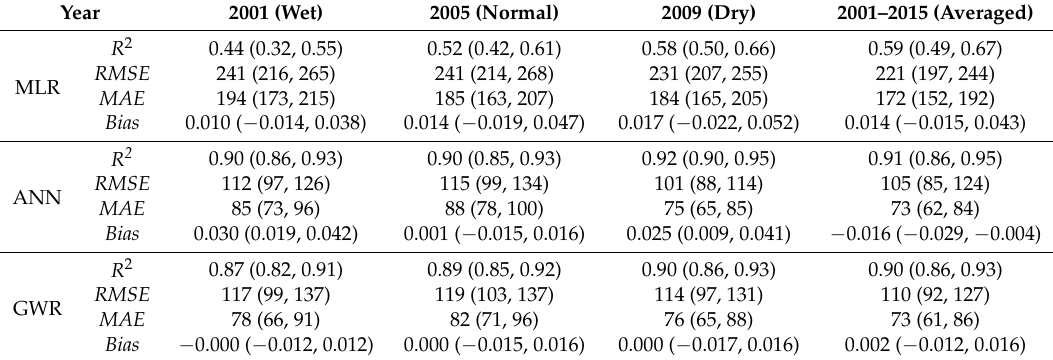
Figure 6. Box plots of performance metrics for different models: ( a ) R 2 ; ( b ) RMSE ; ( c ) MAE ; ( d ) Bias. Table 1. Comparison of annual precipitation data from TRMM 3B43 and estimates based on MLR, ANN, and GWR models (95% confidence intervals are in parentheses).